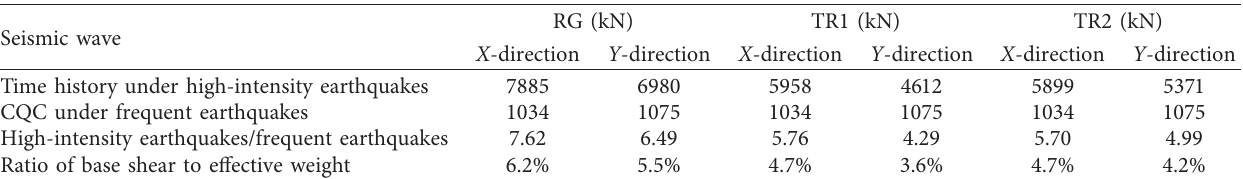
Table 5: The maximum base shear.